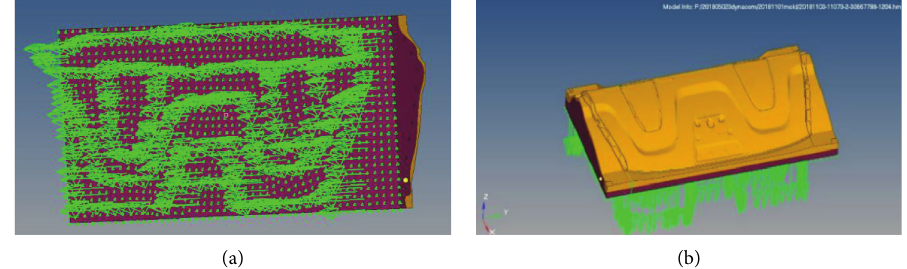
Figure 11: Boundary condition diagram of the lower die definition. (a) The lower die defines the boundary conditions. (b) The lower die defines the boundary